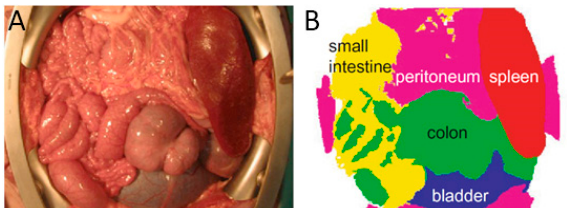
Figure 5. Use of HSI for organs identification in pig’s abdominal surgery performed in [61]. ( A ) RGB image from pig’s abdominal cavity and organs; ( B ) Segmentation map obtained after HS image processing and analysis, where the different organs are identified using different colors.